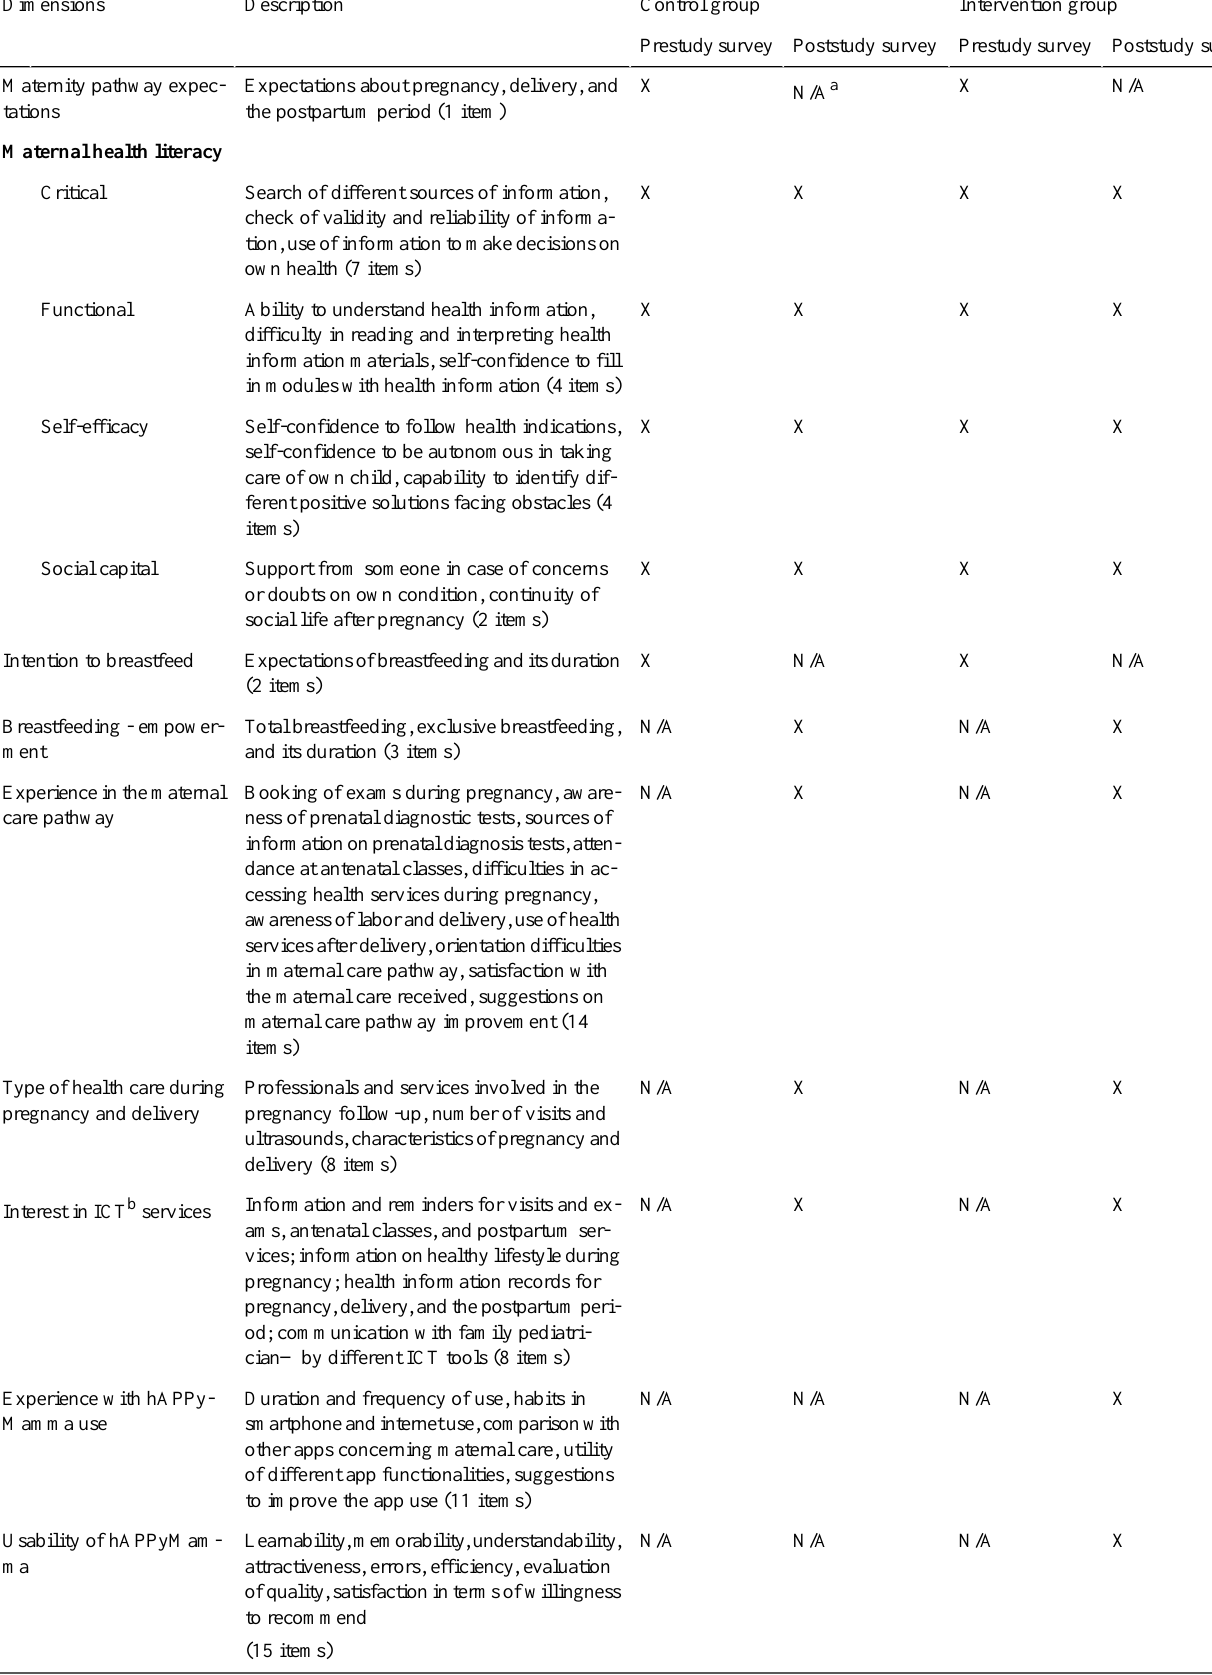
Intervention groupControl